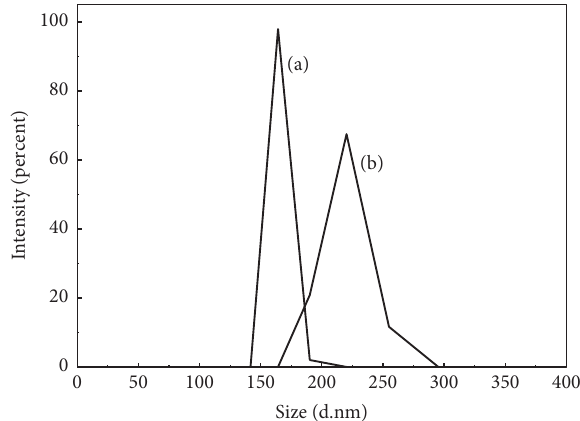
Figure 5: Size distributions of the SA/chitosan particles loaded with CS measured at different times: (a) after 1h; (b) after 3 h (the sample was prepared at the collected distance of 6cm, the stirring rate of 800rpm, the flow rate of 0.6mL/h, and applied voltage of 16kV; the weight ratio of SA to CS was 5:1).